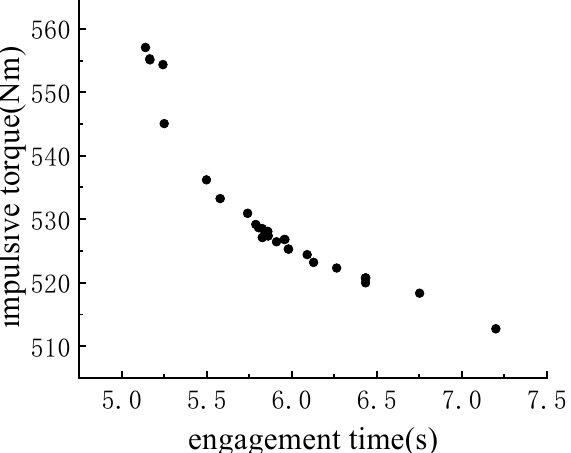
Figure 29. Multi-objective optimization results for engagement time/impact torque.